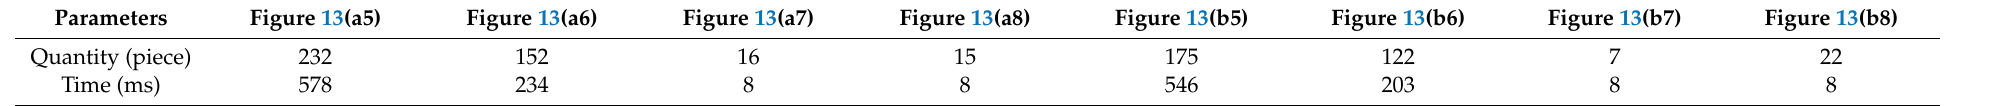
Table 2. Comparison of image feature extraction when the threshold value of Hessian matrix determinant response value is 1000.